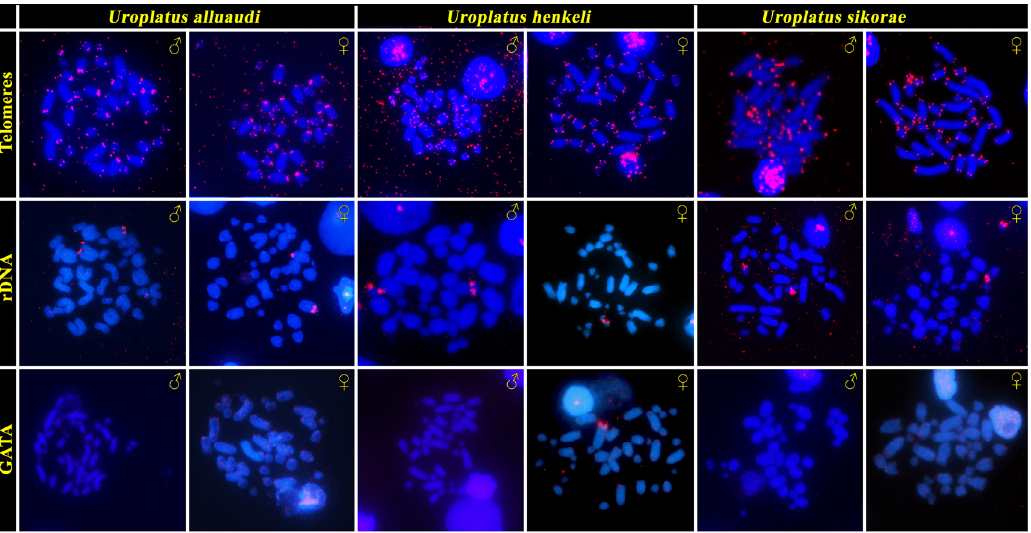
Figure 2. In situ hybridization with probes specific for telomeric repeats, rDNA loci and GATA microsatellite motifs in chromosome spreads from both sexes of the Madagascar leaf-tail geckos ( U. alluaudi, U. henkeli and U. sikorae ).